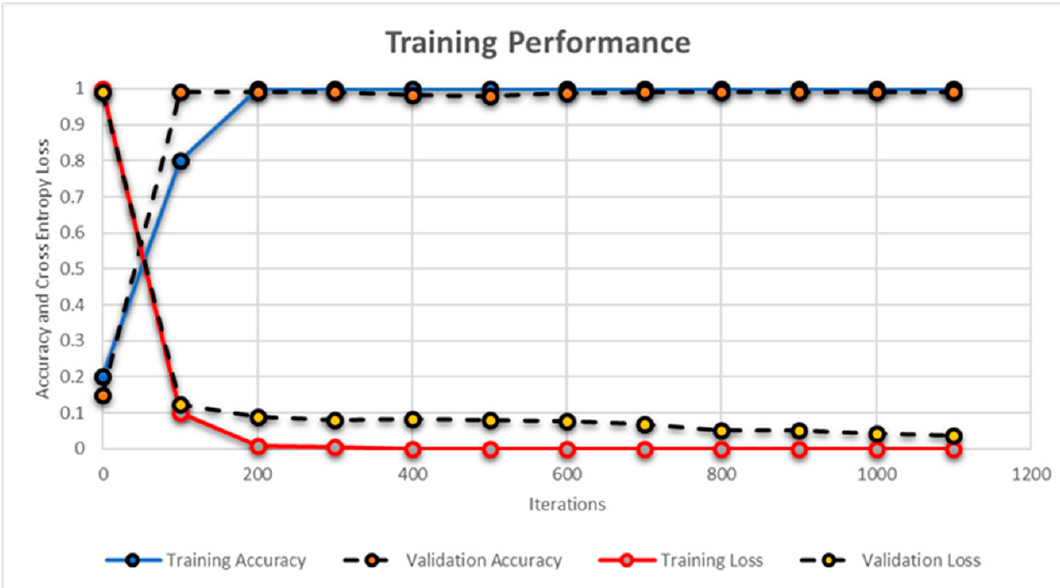
Figure 16. Training performance of the AlexNet model. Blue line shows the training accuracy, red line shows the training loss and the dashed black lines shows the validation accuracy and validation loss. Sensors 2019 , 19 , x FOR PEER REVIEW